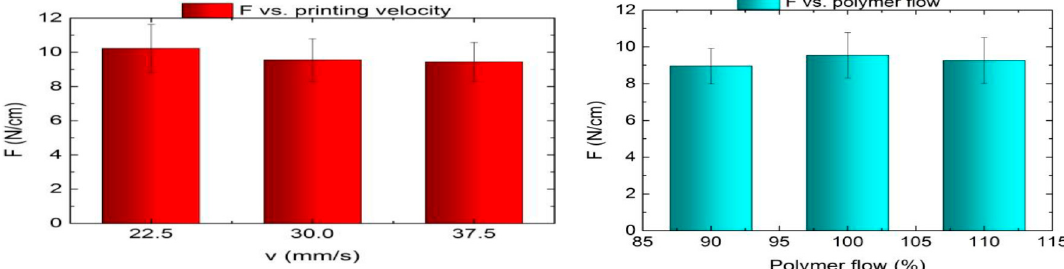
Figure 5. Example of the dependence of the adhesion force on the printing speed ( left ) and polymer flow ( right ) [77], at the specific conditions and materials reported in [77], tested according DIN 53,530 and evaluated according DIN ISO 6133.